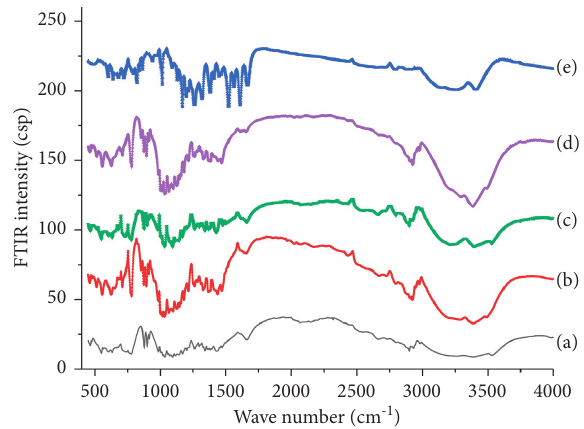
Figure 4: FTIR spectra of (A) α -lactose monohydrate, (B) porous lactose, (C) α -lactose monohydrate after quercetin loading, (D) porous lactose particles after quercetin loading, and (E) quercetin.